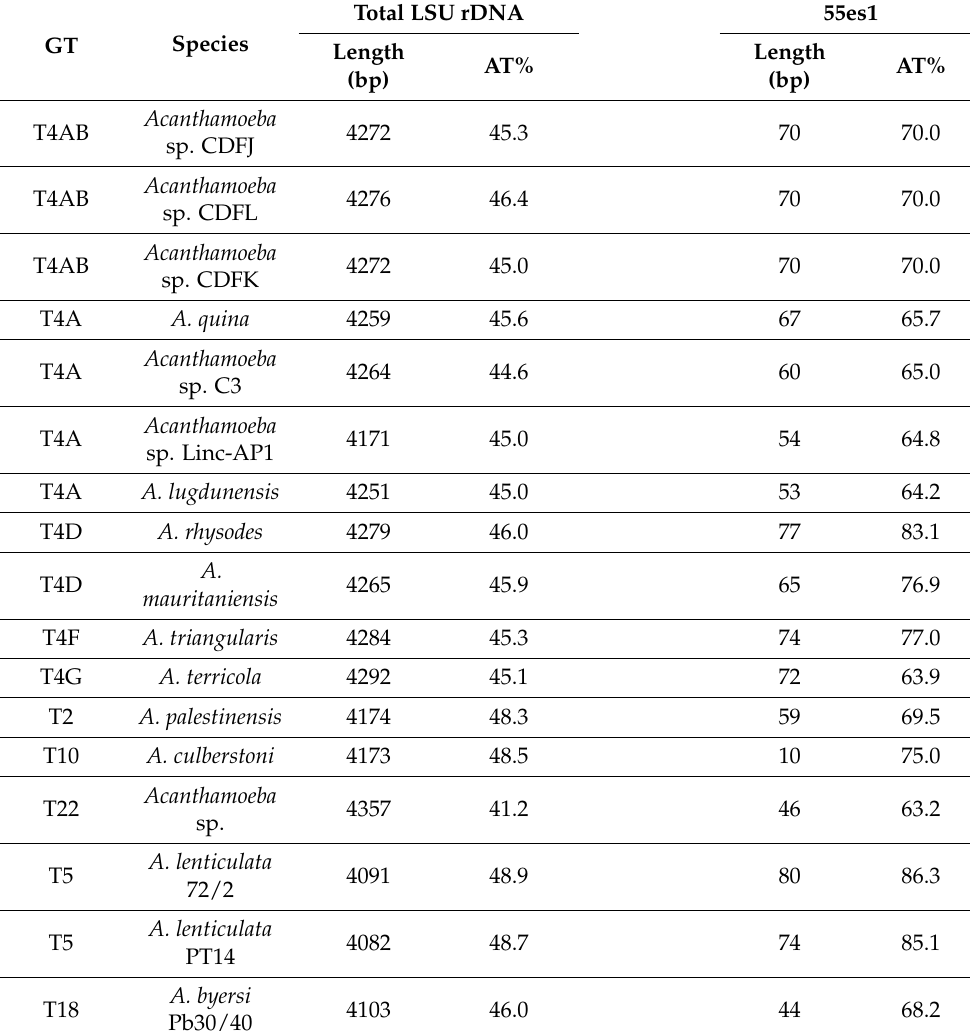
Table 4. AT percentage values for Acanthamoeba LSU rDNA